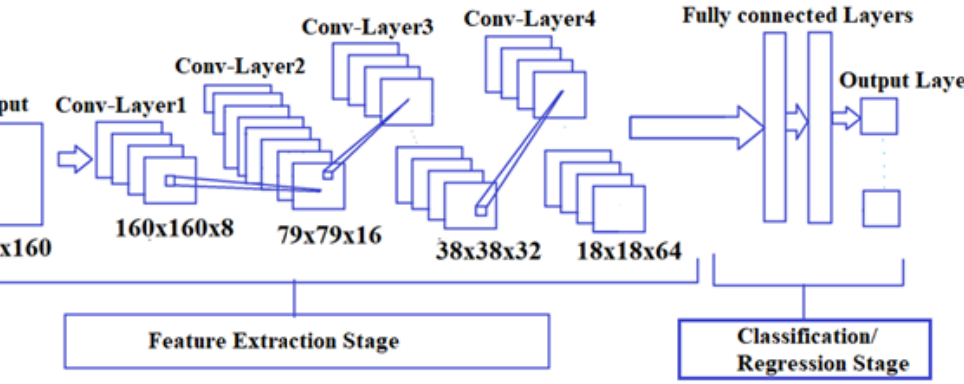
Figure 3. Block diagram of CNN for multi-class classification and multi-output regression.